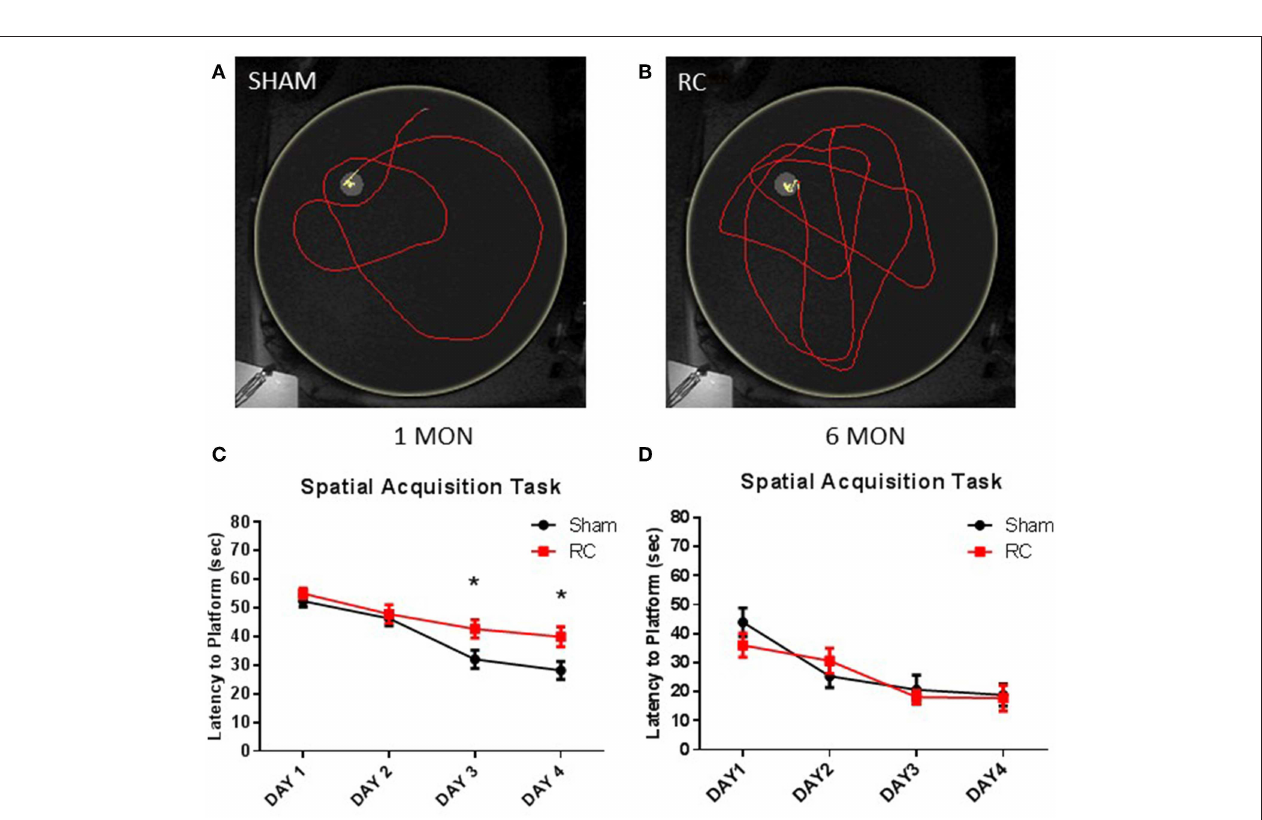
FIGURE 2 | Spatial acquisition task. Trace within the MWM tank (yellow circle) represents swimming to search for the hidden platform to escape from the water (yellow trace—platform; red trace—outside of platform) for a sham (A) or a repeated concussed rat (B) . At 1 month post-injury (C) , results showed that the average latencies to locate the hidden “escape” platform were significantly longer in rats sustained repeated concussive impacts (RC) over the last 2 days of the MWM testing compared to sham controls (group n = 24; * p < 0.05). At 6 months post-injury (D) , no differences were detected between concussed rats (RC) and sham controls (group n =